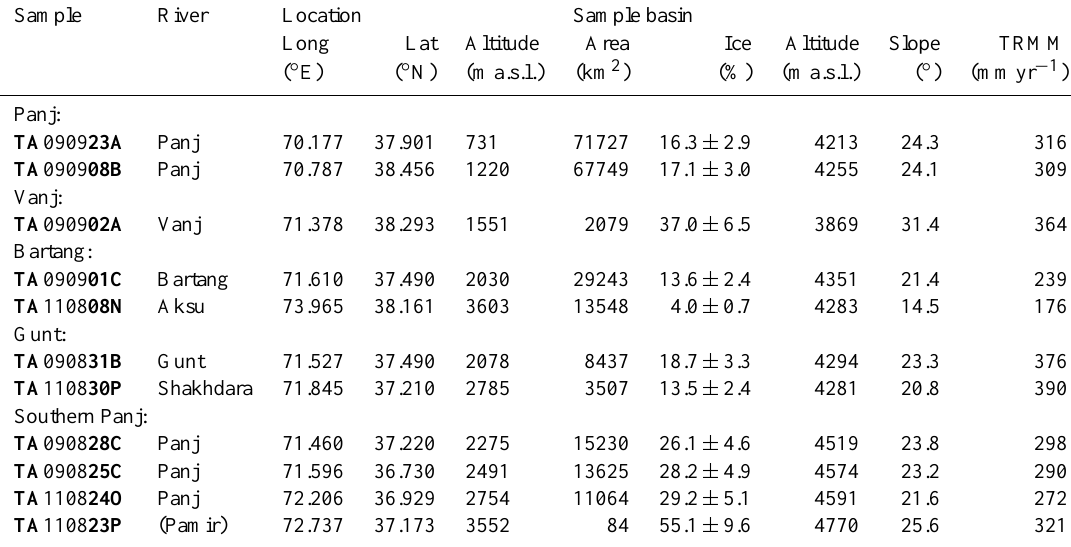
Table 1. Details on sampling sites and related upstream drainage area (sample basin). Ice: permanent ice and snow cover, based on the year 2010 from MODIS MCD12Q1 (Strahler et al., 1999); the uncertainty given represents the standard deviation of MODIS MCD12Q1 between 1998 and 2012. Altitude, slope and precipitation represent the median of the value distribution within sampled basins (see Fig. 2) calculated from the ASTER GDEM (30m resolution). The rainfall data reflect the annual mean precipitation, based on the Tropical Rainfall Measuring Mission (TRMM) product 3B42 V7, 1998–2012 (Huffman et al., 1997, 2007). Bold letters in sample names indicate notations used in the text and